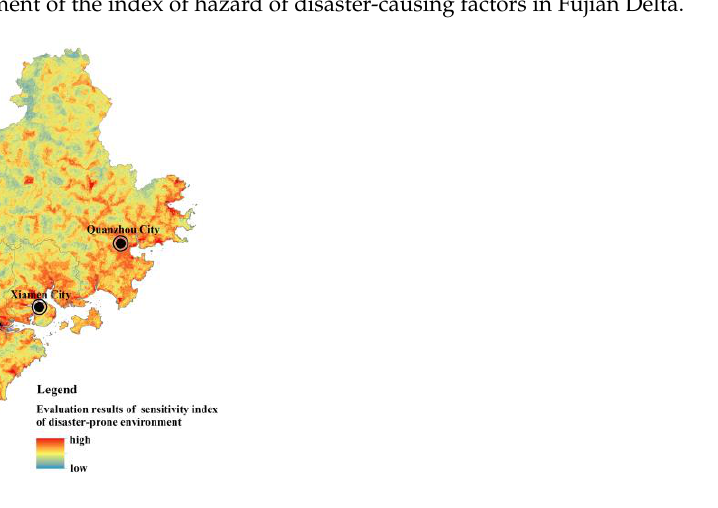
Figure 9. Assessment of the index of sensitivity of disaster-prone environments in Fujian Delta.